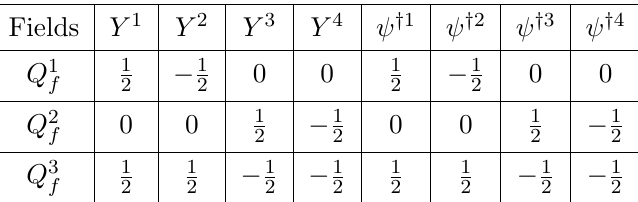
Table 1 . Charges of (cid:12)elds under three U(1) generators of SU(4) R